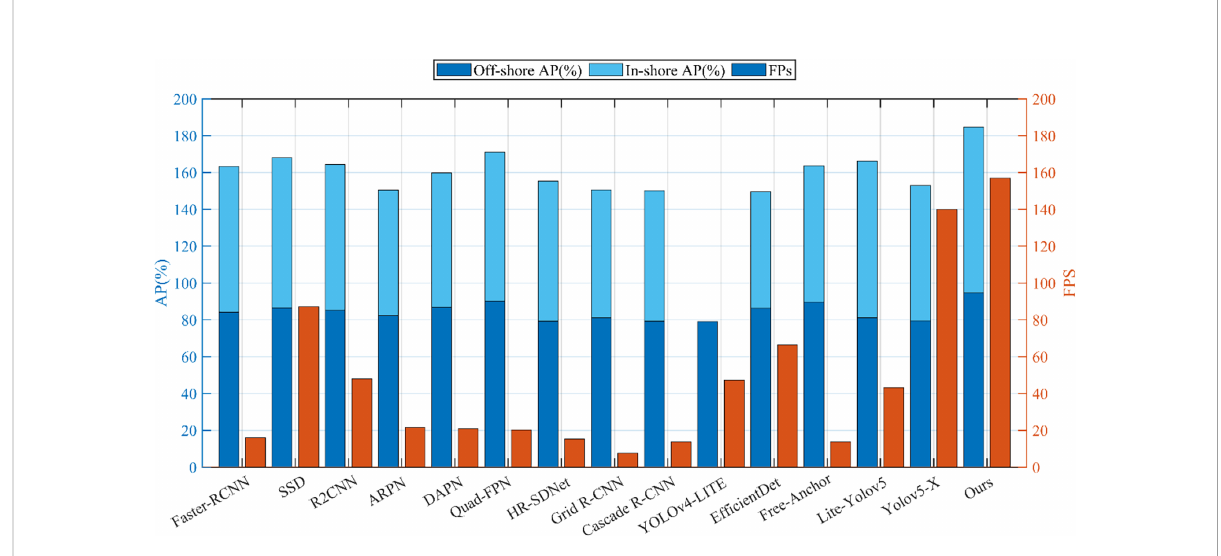
FIGURE 10 Performances of AP and FPS for various CNN-based techniques on offshore and inshore ships for AirSARship